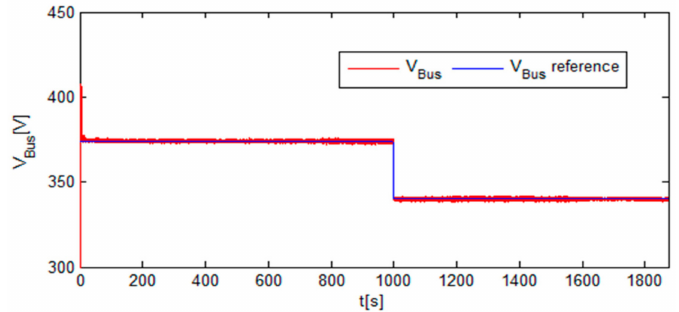
Figure 24. DC-link voltage control result.